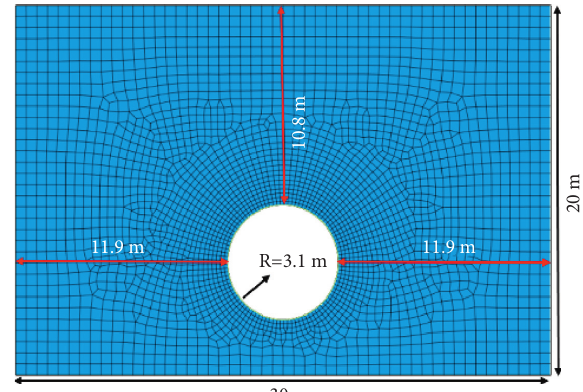
Figure 5: Numerical simulation of model test